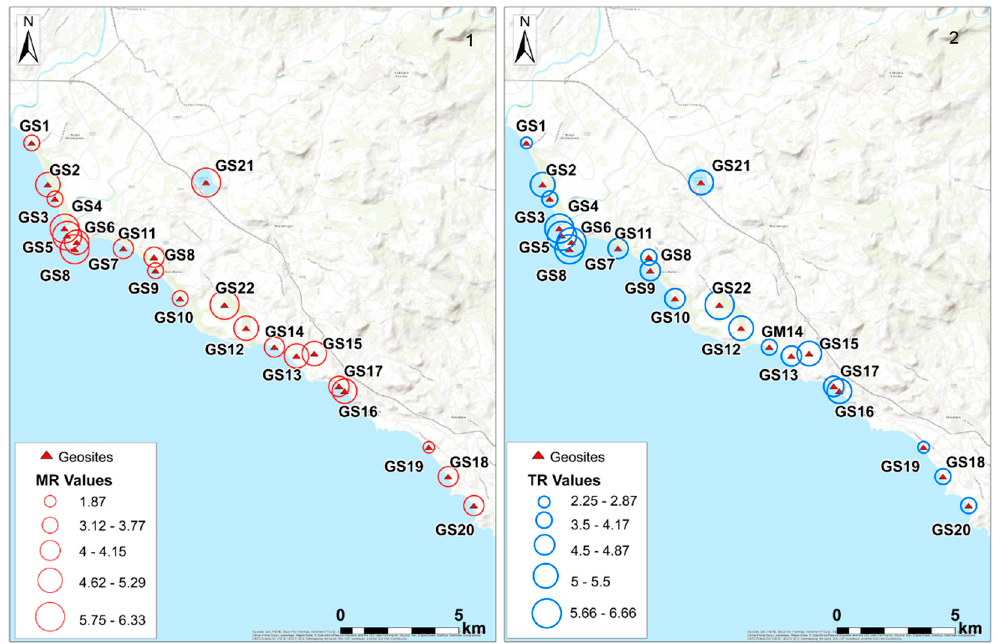
Figure 8. Geosite distribution according to management ranking ( 1 ) and tourism ranking ( 2 ) in Sicily study area (GEOMAL).